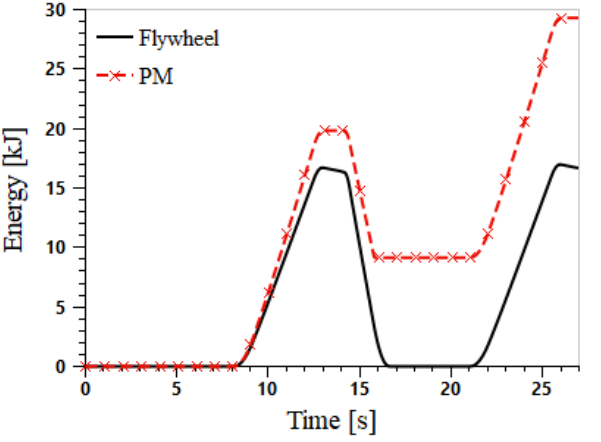
Figure 21. Energy curves of the flywheel and PM of the proposed system when the excavator bucket is fully loaded.